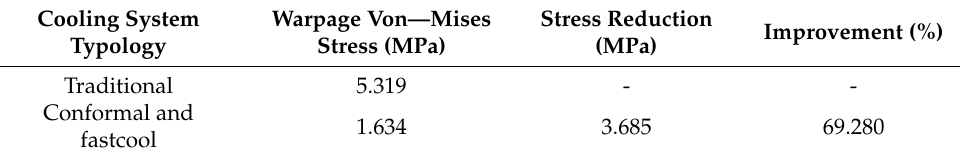
Table 11. Warpage Von—Mises stress for the analyzed cooling